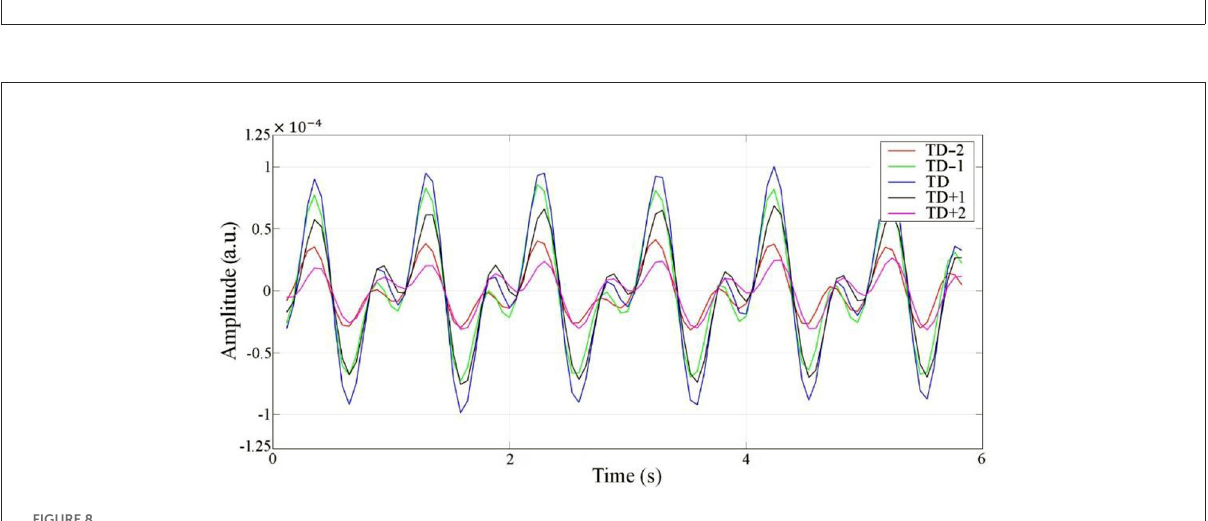
FIGURE7 The preprocessing performance on heartbeat UWB radar echo (A) before and (B) after preprocessing.